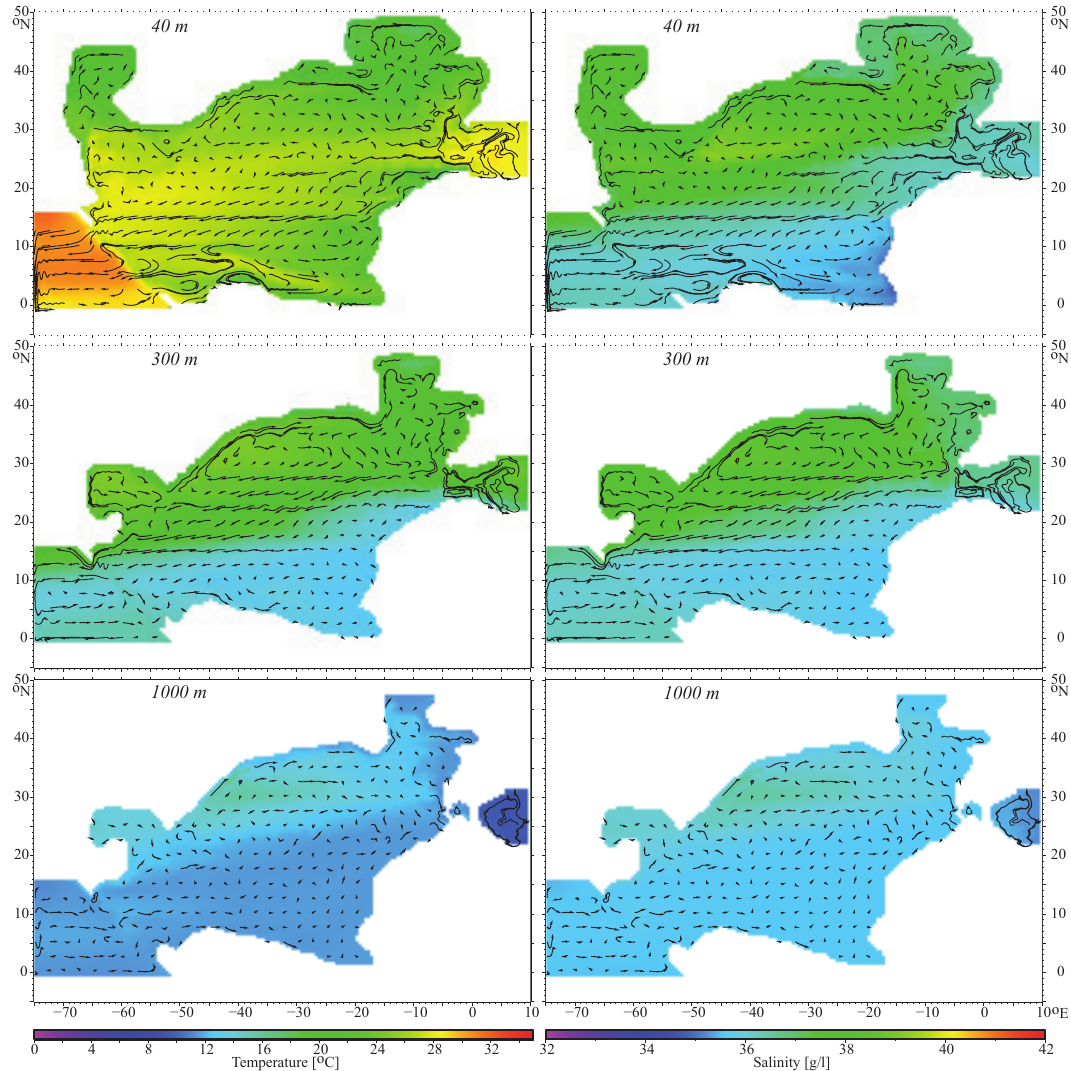
Fig. 3. REF tracer patterns. Temperature (left) and salinity (right) slices taken at depths of 40, 300 and 1000m. The paths of water particles of every fifth grid point followed for 42, 84 and 114 days are overprinted on the tracer colours. In order to visualize low velocity currents at deeper levels, the time during which water particles are followed increases with